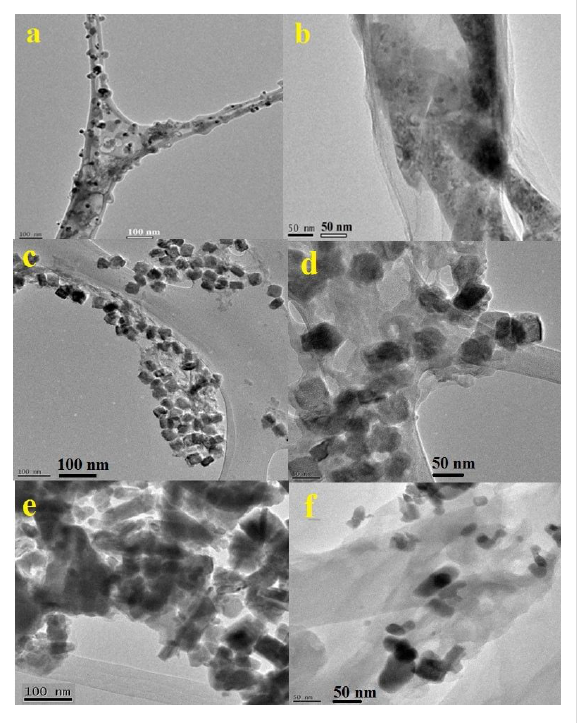
Figure 5: TEM images of the a) CN-5, b) GCN-5, c) CN-10, d) GCN-10, e) CN-20 and GCN-20 nanoflakes and quantum